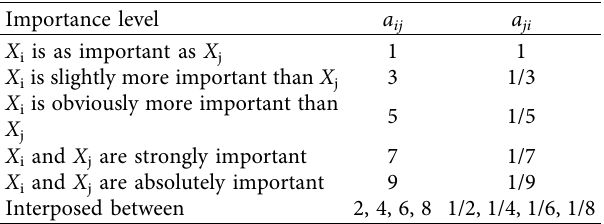
Figure 3: Unascertained measurement function of (a) powder factor; (b) limit vibration velocity; (c) effective casting rate; (d) looseness coefficient; (e) fragmentation distribution; (f) muck pile shape; (g) boulder generation; (h) destruction degree of coal seam bench; and (i) dust pollution. Table 3: Meaning of important